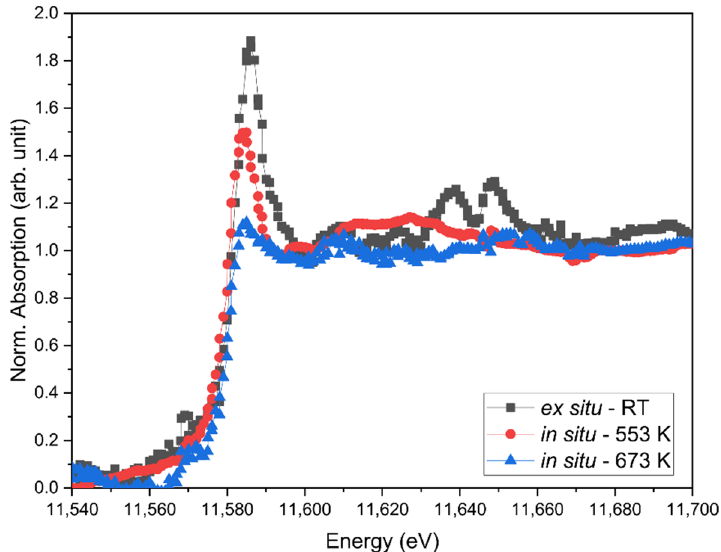
Figure 6. Normalized X-ray absorption near-edge spectra (XANES) sum spectra of the whole Figure 6. Normalised XANES sum spectra of the whole measured slices of the Pt/Al 2 O 3 catalyst measured slices of the Pt/Al 2 O 3 catalyst under the conditions indicated. This represents the total under the conditions indicated. This represents the total signal derived from each pixel of the signal derived in Figure 7. Overview of the sample measured at 553 K; ( a ) reconstructed slice ED-XAS-CT image series as each energy position. with the capillary masked out and color-coding depicting the absorption intensity at 11,585 eV; ( b ) extracted single particle of the same slice with marked regions of interest; ( c ) XANES spectra ex- tracted from each region of interest, compared with the sum spectra of the whole slice.